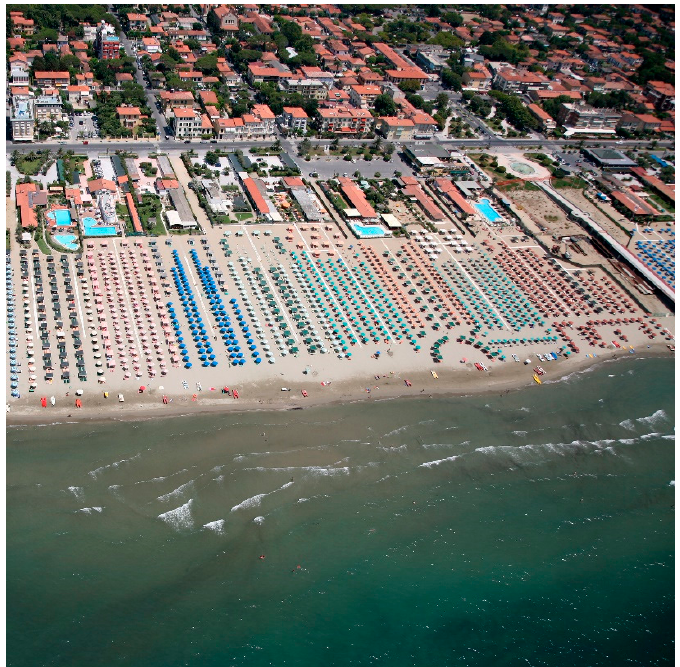
Figure 11. The beach at Marina di Pietrasanta, in the sediment transport convergence area.